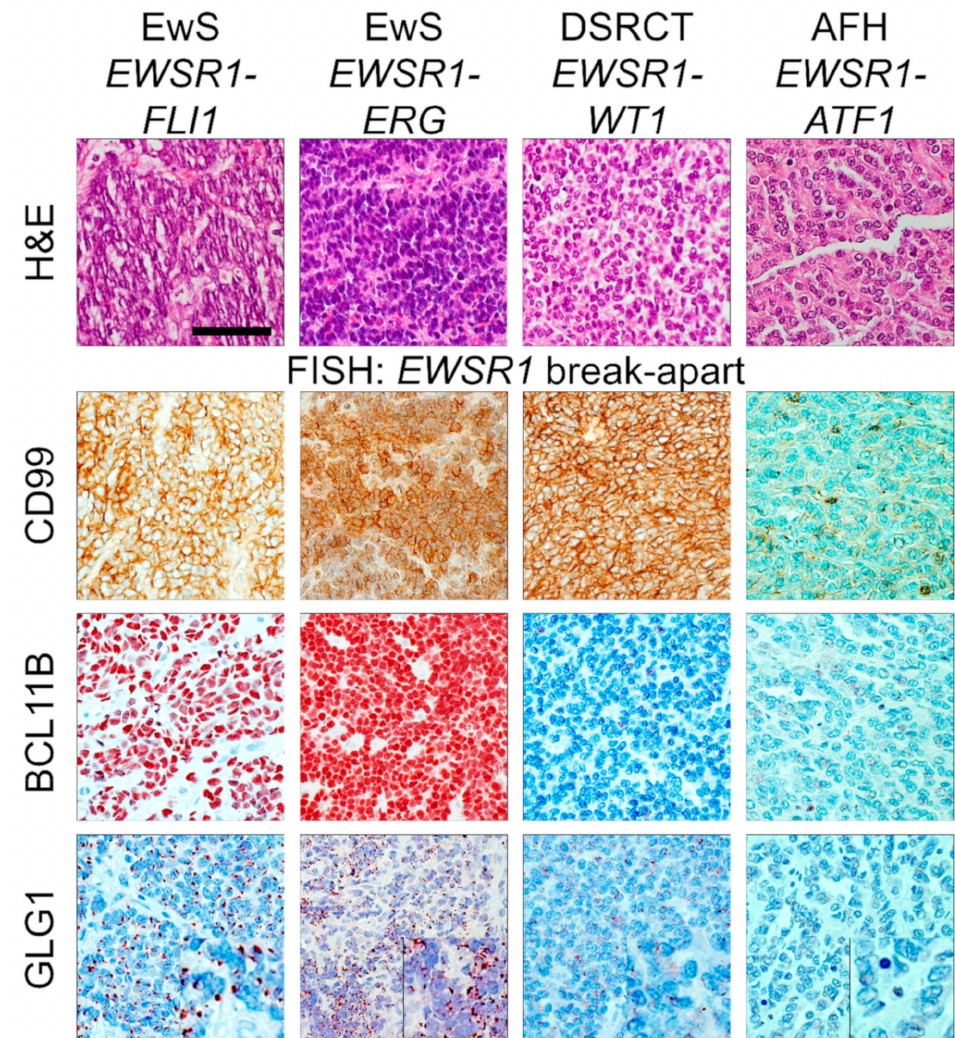
Figure 1. Immunohistochemistry (IHC) for CD99 and fluorescence in situ hybridization (FISH) for EWSR1 break-apart are not su ffi cient to constitute the diagnosis EwS. From left to right: representative micrographs of Ewing sarcoma (EwS) positive for EWSR1-FLI1 or EWSR1-ERG , desmoplastic small round cell tumor (DSRCT) positive for EWSR1-WT1 , and an angiomatoid fibrous histiocytoma (AFH) positive for EWSR1-ATF1 , stained with H&E, or for CD99, BCL11B, and GLG1. The scale bar applies to all micrographs and indicates 40 µ m, insets for GLG1 are enlarged by factor two. In all cases, an EWSR1 break-apart was detected by